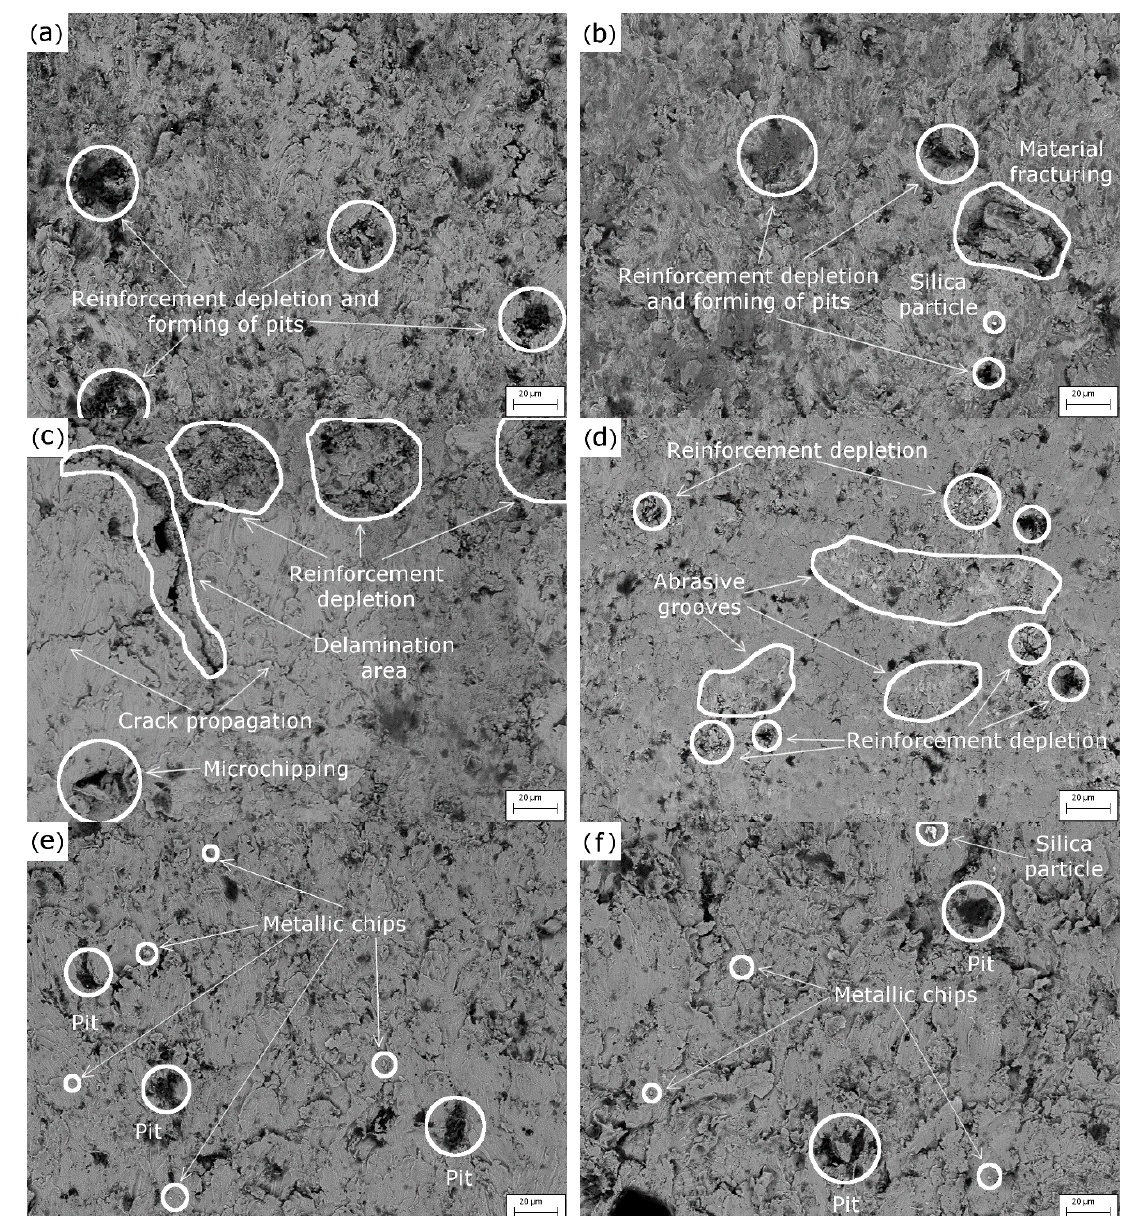
Figure 9. The topography of the wear surfaces after AEW: ( a ) MAS (TiC–20%NiMo) + AISI 316L; ( b ) RTS (Ti + C) + AISI 316L; ( c ) MAS (Cr 3 C 2 –20%Ni) + AISI 316L; ( d ) Cr 3 C 2 –25%NiCr (Amperit); ( e ) AISI 316L; ( f ) Hardox 400.